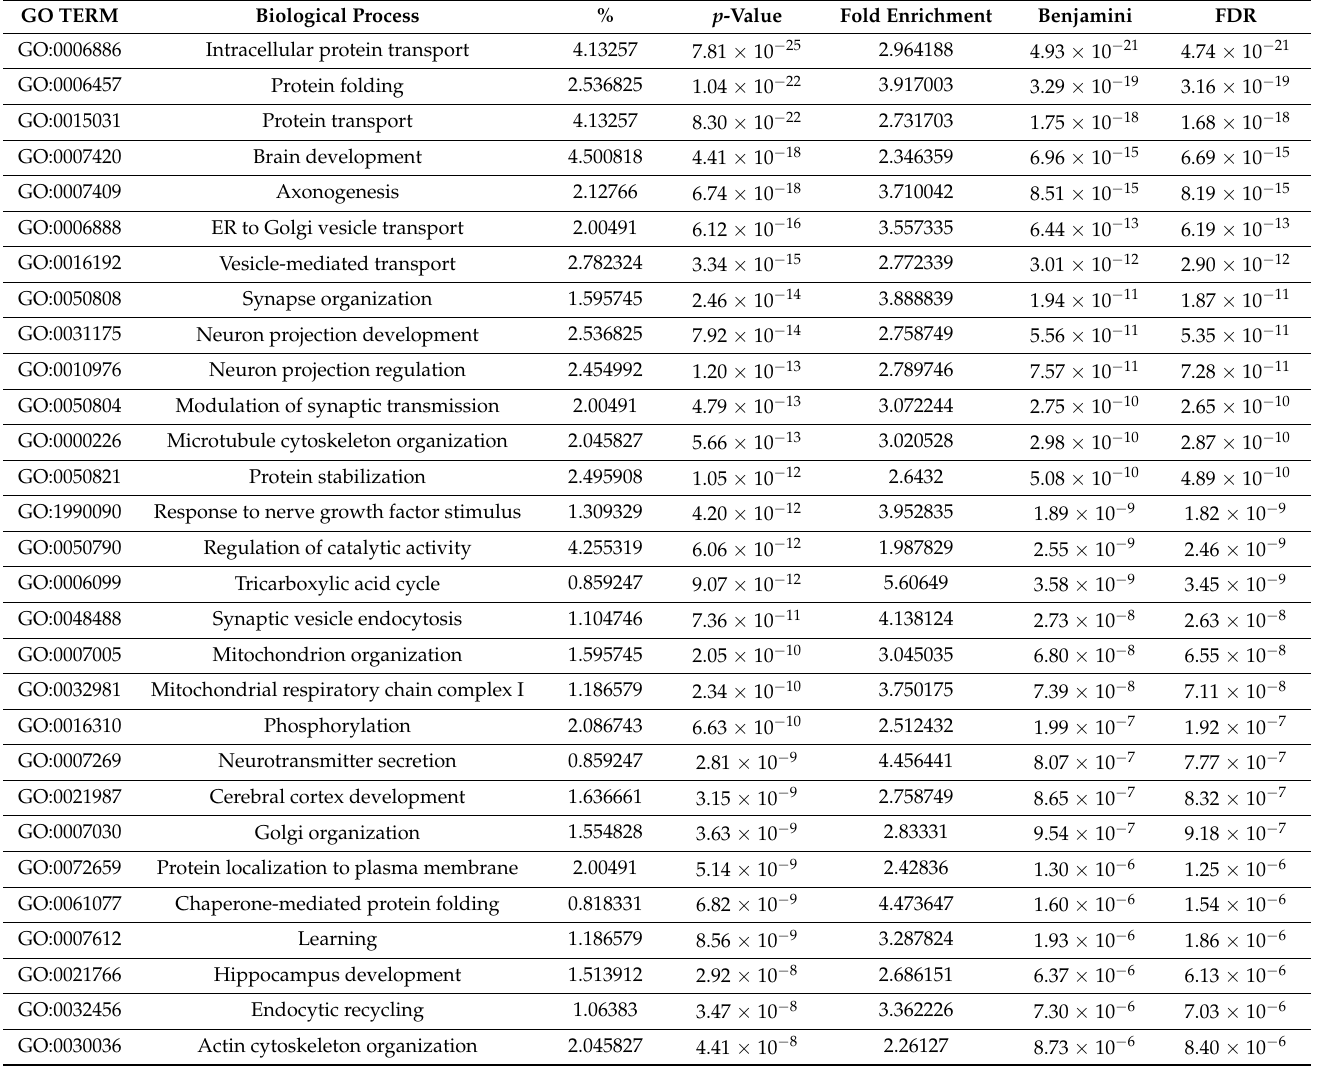
Table 2. Pathway analysis using DAVID showing the biological functions (GOTERM_BP_DIRECT) most affected by PHF8 knockdown, ranked by gene count, in primary cortical neurons. The full list containing all hits can be obtained in Supplementary Table